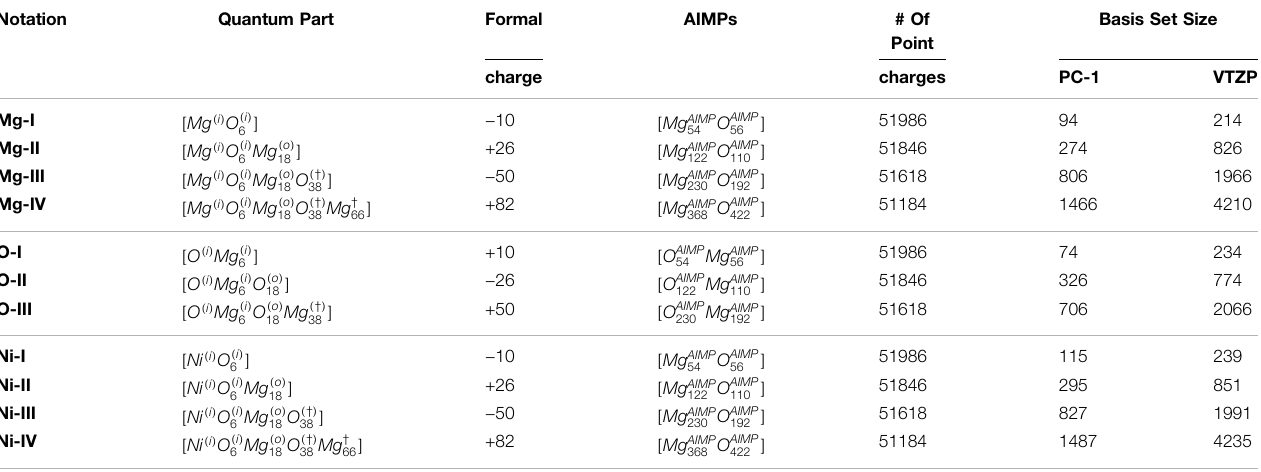
TABLE 1 | Notations for the clusters, used in the study, indicating the quantum part, AIMPs and point charges. The basis set size is presented for PC-1 (used in the current study) and for a triple- ζ quality basis set. Notation